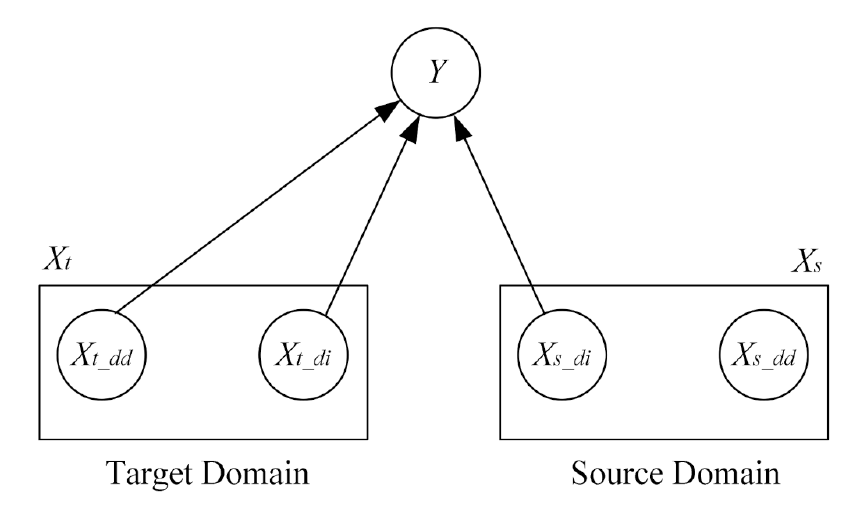
Figure 2. Discriminant Process of TF-Mnt